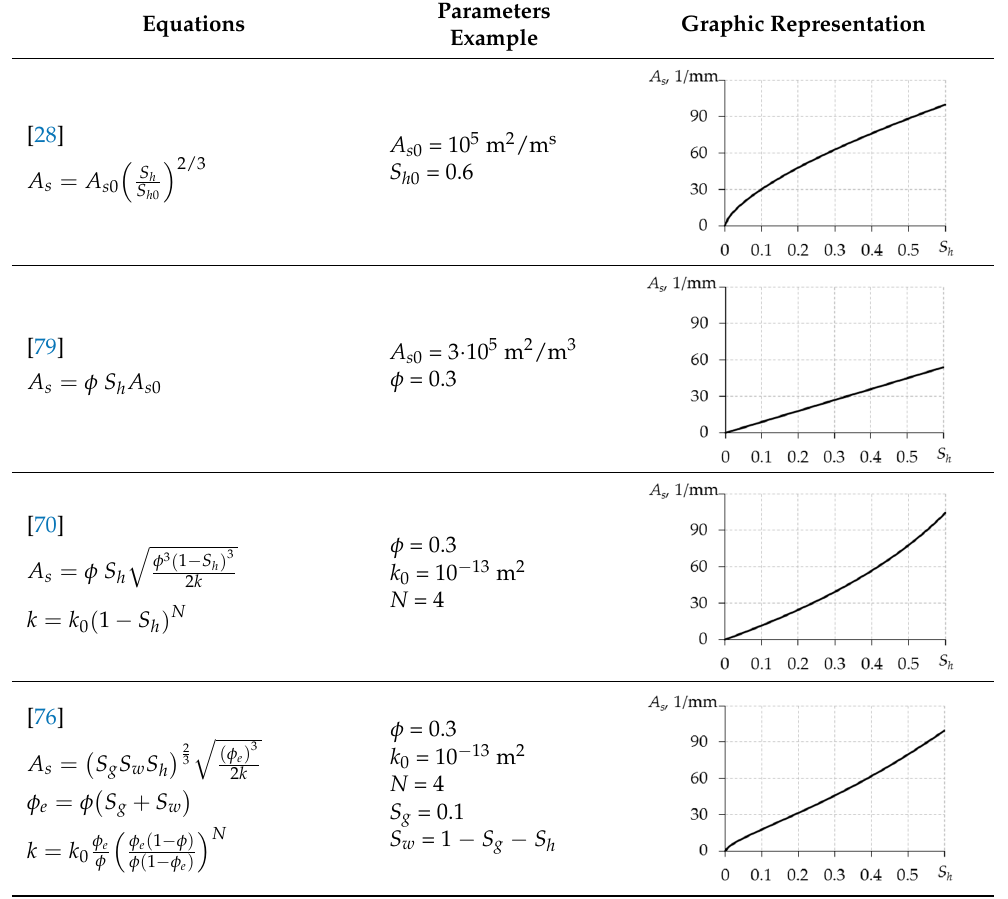
Table 3. Equations for calculating A s .